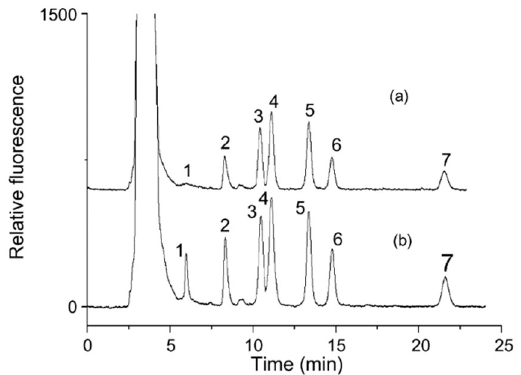
Figure 2. Chromatograms of seven 6-oxy-(acetylpiperazine)fluorescein (APF)-derivatized fatty acids in ( a ) healthy human serum and ( b ) sample containing 0.2 µM fatty acid standards. Peaks: 1, lauric